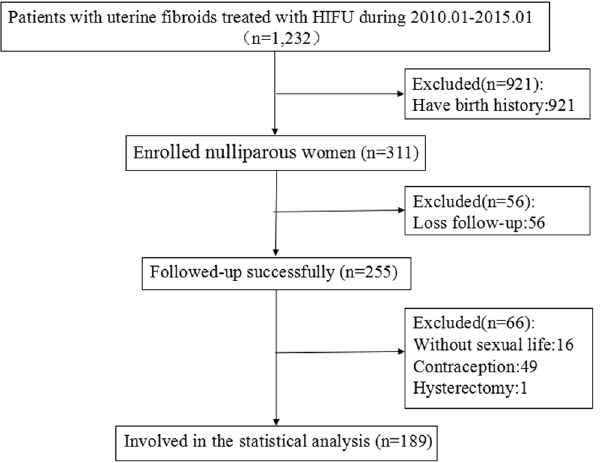
Figure 2. CONSORT diagram showing the disposition of patients in this